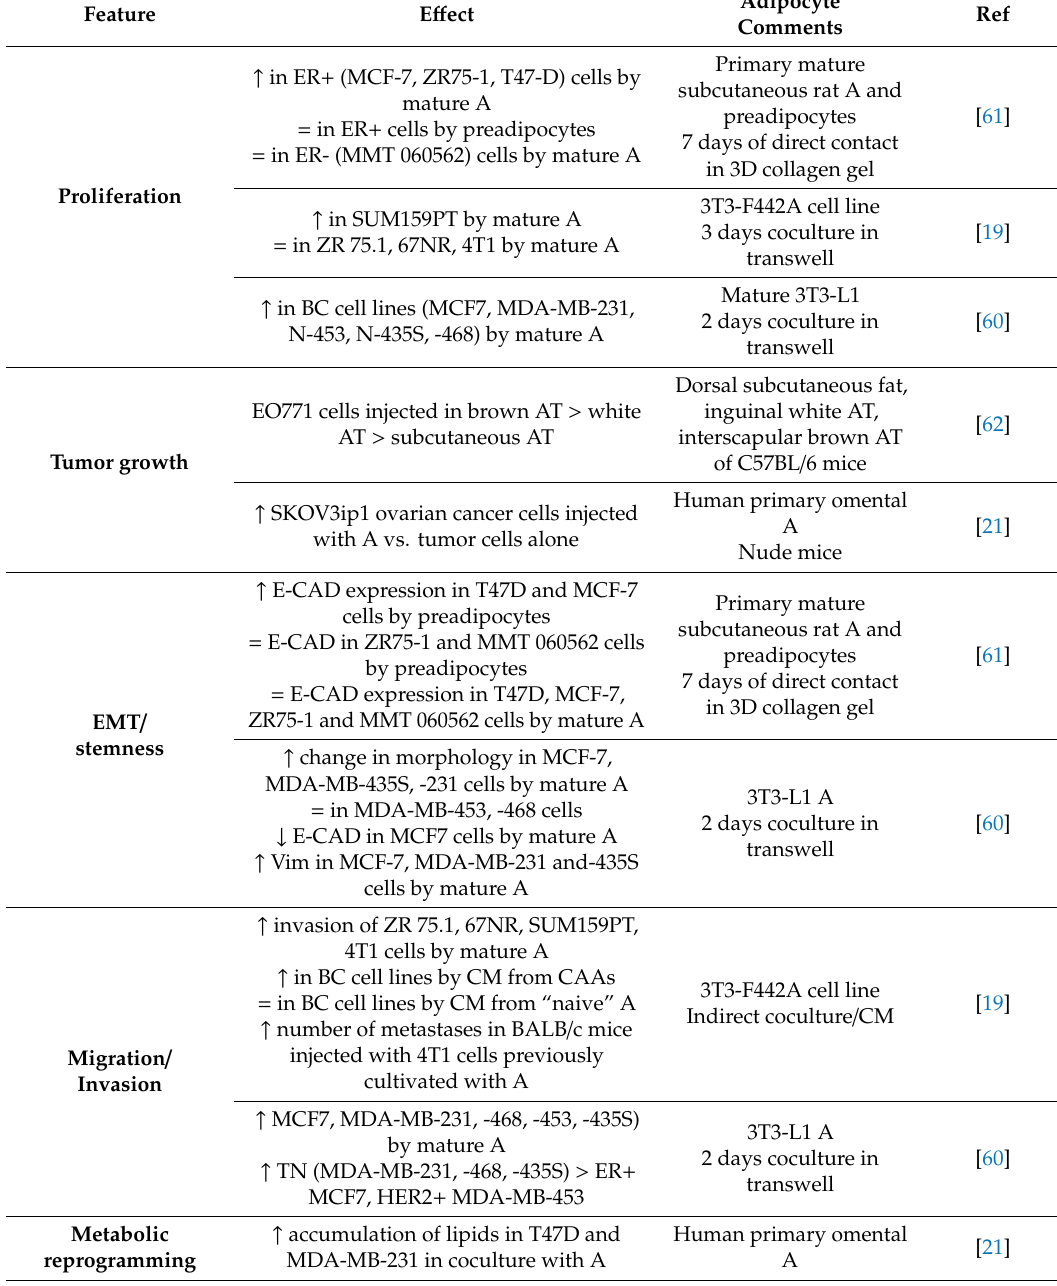
Table 2. Pro-tumorigenic e ff ect of the adipocyte-tumor cell crosstalk.